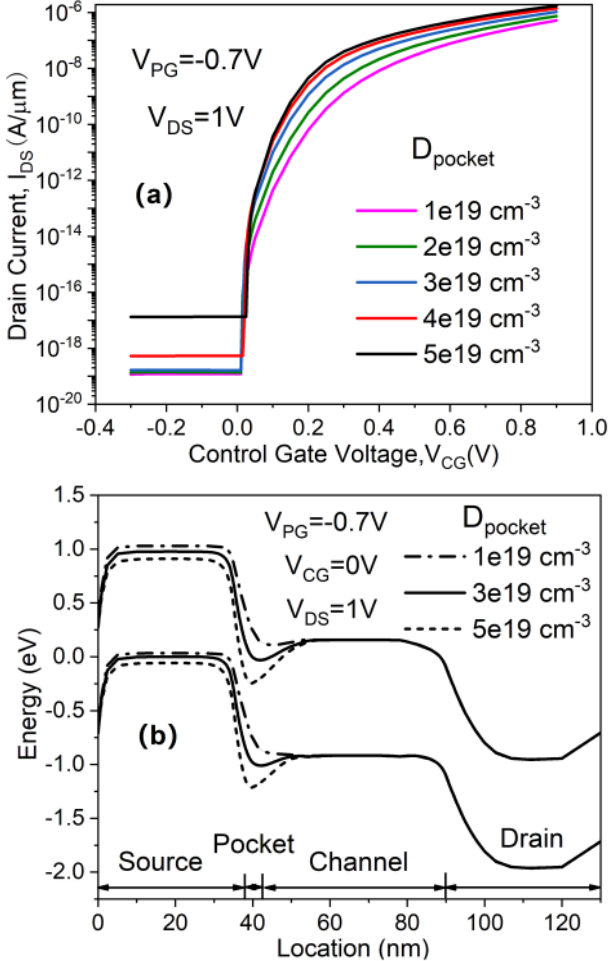
Figure 6. Impact of D pocket on ( a ) transfer characteristics and ( b ) OFF-state energy band diagram of the in-built N + pocket ED-TFET.